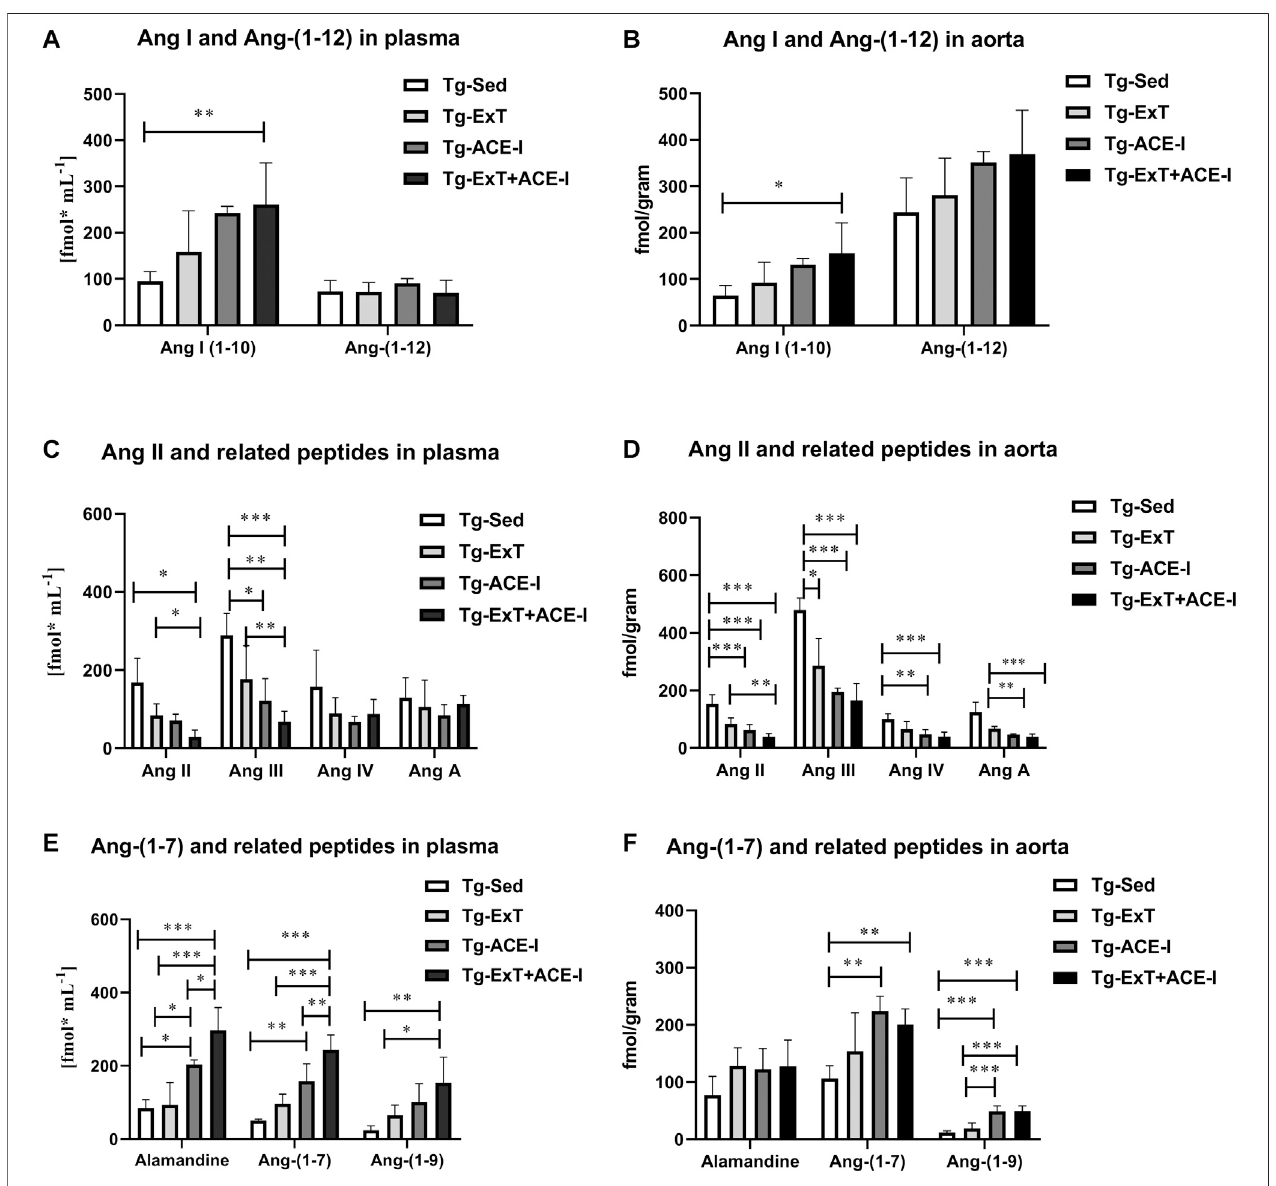
FIGURE 1 | Plasma and aortic angiotensin pro fi le in exercise-trained, ACE-I – treated, or after applied combined therapy in Tg α q*44 mice as compared to nontreated and sedentaryTg α q*44 mice.All applied therapiesimproved theACE/ACE-2 balanceoftheRAAS, decreasing concentrationofAng IIand III (C and D), and increasing the concentration of alamandine, Ang-(1 – 7), Ang-(1 – 9) (E and F) , and Ang-(1 – 10) (A and D) . An increased level of Ang-(1 – 12) in the aorta (B) but not in plasma (A) was also observed. Values were presented as mean ± SEM; n (cid:1) 4 – 9. * p < 0.05, ** p < 0.01, and *** p < 0.001. Statistics: one-way ANOVA or nonparametric Kruskal – Wallis test between Tg-ExT, Tg-ACE-I, Tg-Sed, and Tg-Exc+ ACE-I for each angiotensin.